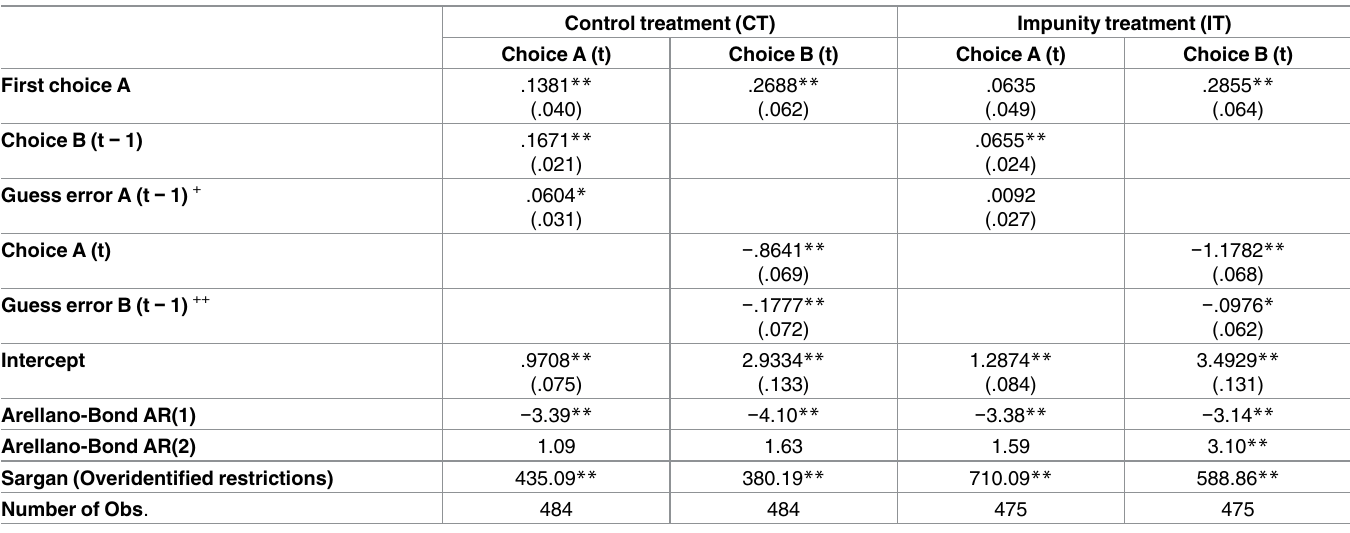
Table 3. Regressions on the determinants of